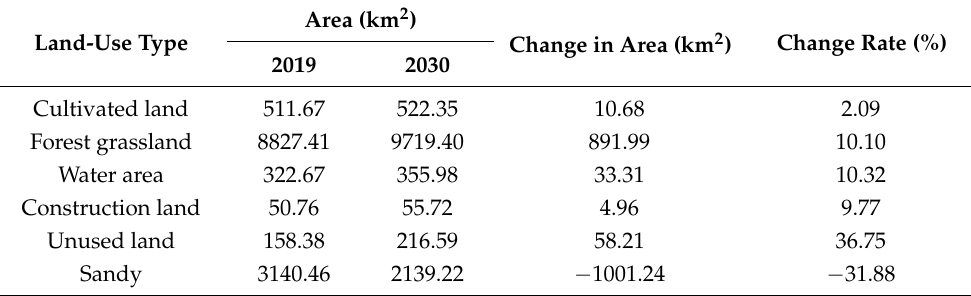
Figure 11. Spatial projections of land use and habitat quality along the Yellow River section of the Hobq Desert in 2030. ( a ) Land-use distribution. ( b ) Habitat quality. Table 9. Land-use forecast along the Yellow River section of the Hobq Desert in